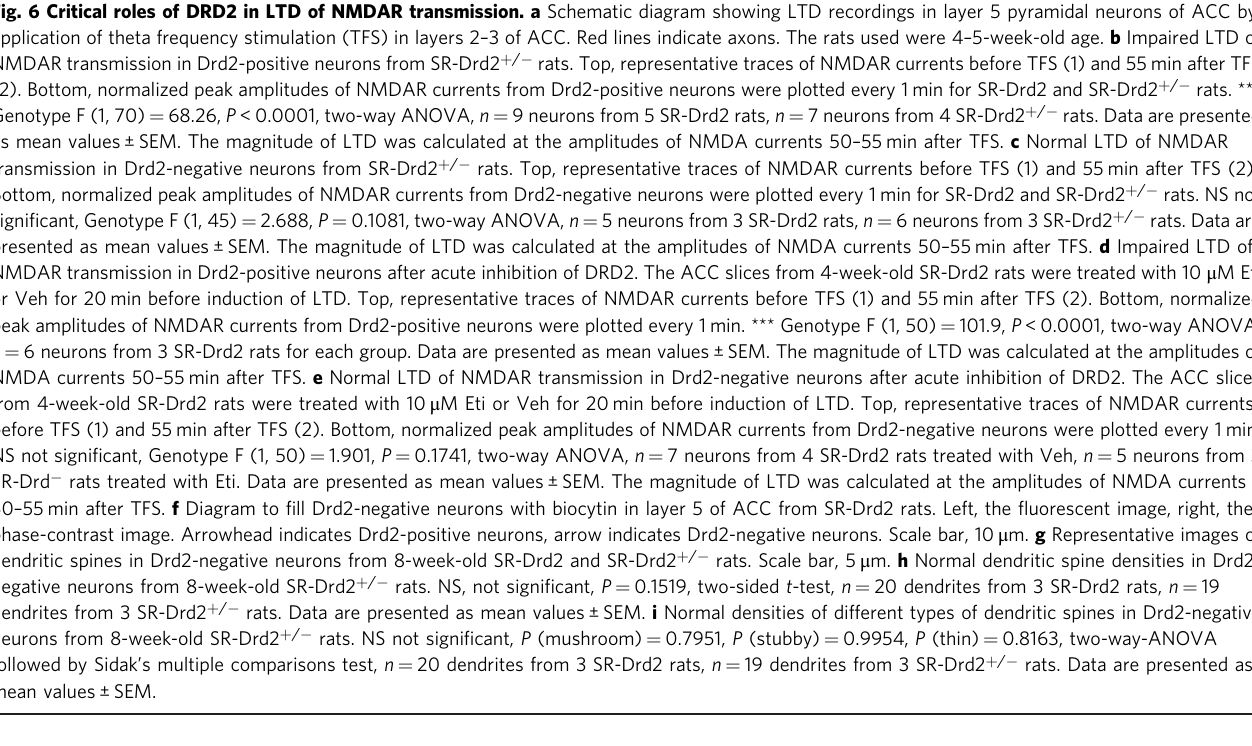
slices were mounted with Vectashield mounting medium (Vector Labs) and images were taken by Leica TCS SP8 confocal microscope. We used ×20 oil immersion objective to capture images of pyramidal neurons, for each neuron, z-stacks were captured with the following parameters: z-step: 1 μ m; image size: 1024 ×1024 px; zoom: 0.75×; line averaging: 1; acquisition rate:400 Hz. We used ×63 oil immersion objective to capture images of dendritic spines. The secondary basal dendrites were selected by minimum of 50 μ m and maximum of 110 μ m from the soma. For each dendritic spine, z-stacks were captured with the following parameters: z-step: 0.15 μ m; image size: 1024 × 1024 px; zoom: 3×; line averaging: 4; acquisition rate: 400 Hz. The pixel sizes for x-y are 0.06 μ m.